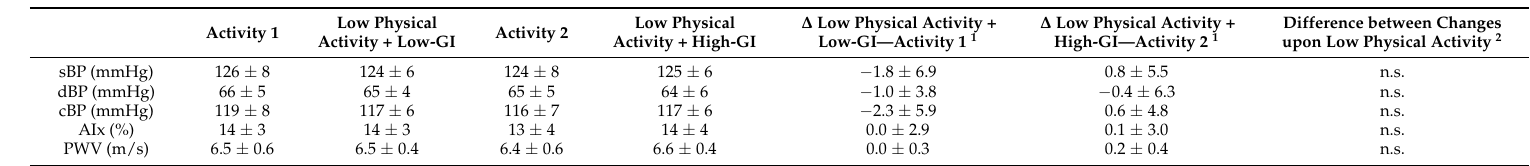
Table 3. Comparison of low physical activity-induced changes in blood pressure and parameters of arterial stiffness between low-GI and high-GI SSB intervention. n =